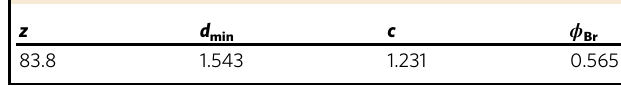
Table 3 Results of the branched mass-fractal analysis using uni fi ed fi t results of both levels